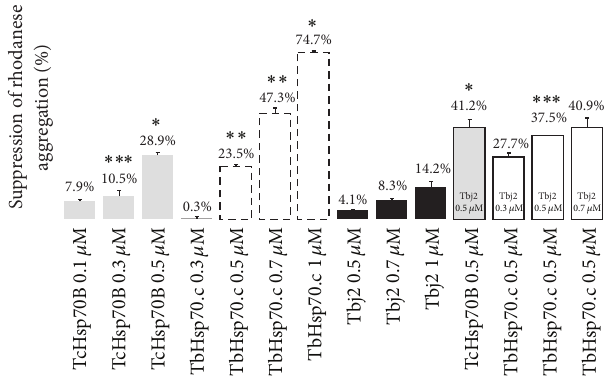
Figure 4: Suppression of MDH aggregation by TbHsp70.c, TcHsp70B and Tbj2. The reaction was initiated by the addition of MDH (0.715 𝜇 M) to the assay buffer at 48 ∘ C; the concentrations of all components are given in the figure. TcHsp70B suppresses aggregation of MDH. TbHsp70.c and Tbj2 both suppress aggre- gation of MDH in a dose-dependent manner. The effect of Tbj2 on the ability of TbHsp70.c and TcHsp70B to suppress MDH aggregation was investigated. Each assay was conducted in triplicate and three independent experiments on independent batches of protein were conducted and the data shown represents that of a typical experiment. The bars represent standard deviations. ∗ 𝑃 < 0.001 , ∗∗ 𝑃 < 0.01 and ∗∗∗ 𝑃 < 0.05